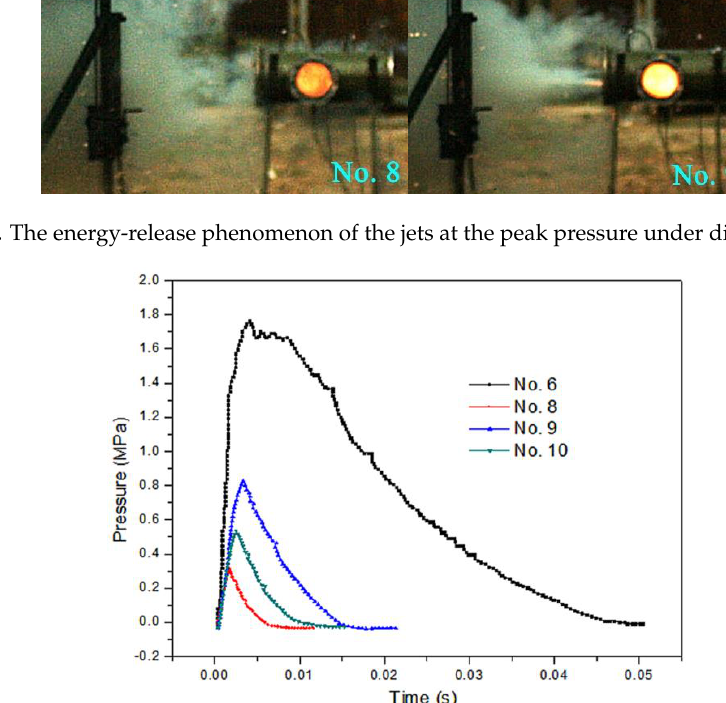
Figure 16. The pressure–time curve of fine-grained Fe / Al energetic jets and control